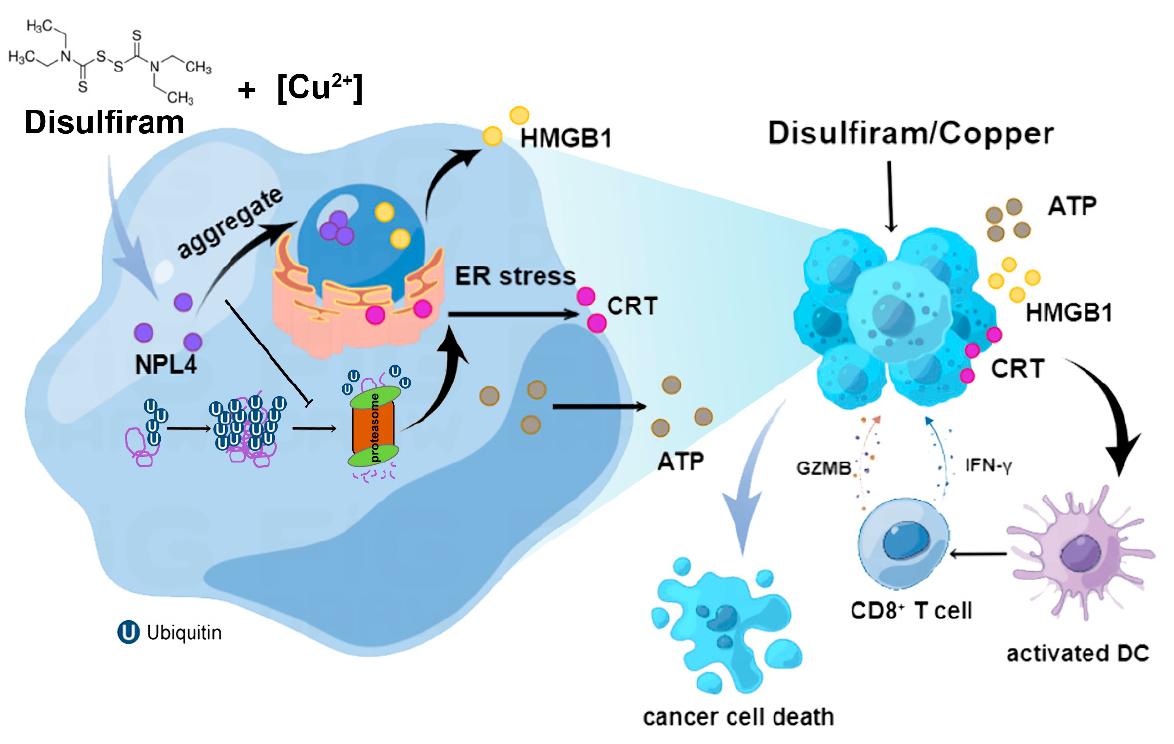
Figure 7. Schematic diagram showing that DSF/Cu induced ICD and activated antitumor immunity in HCC.